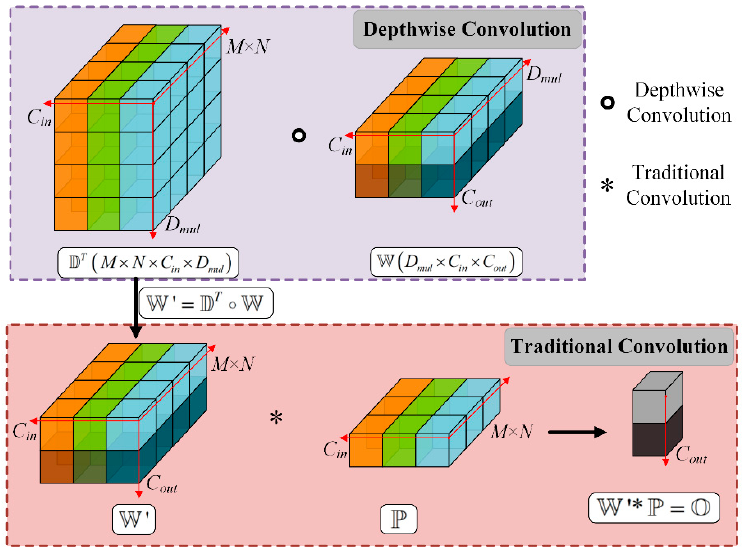
Figure 5. Do-Conv operation